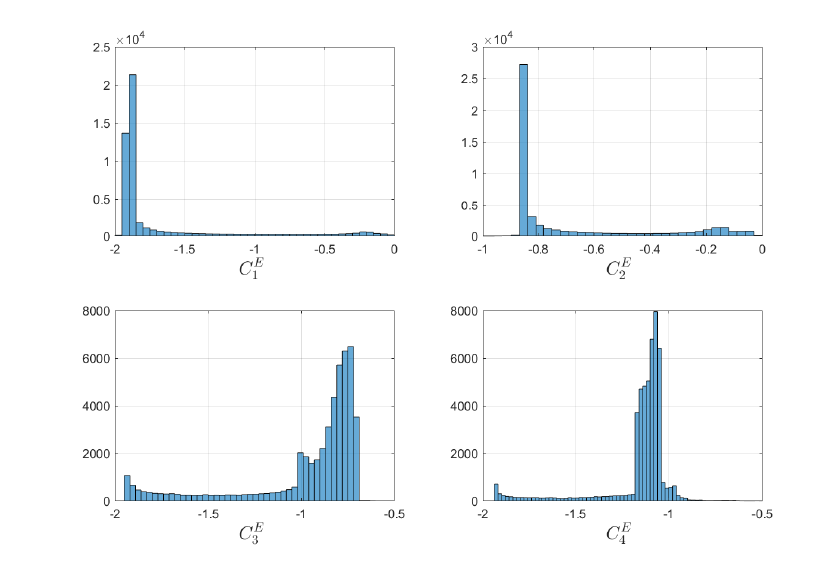
Figure 19. Histogram for the constraints calculated in Equation (33) purely under exclusion